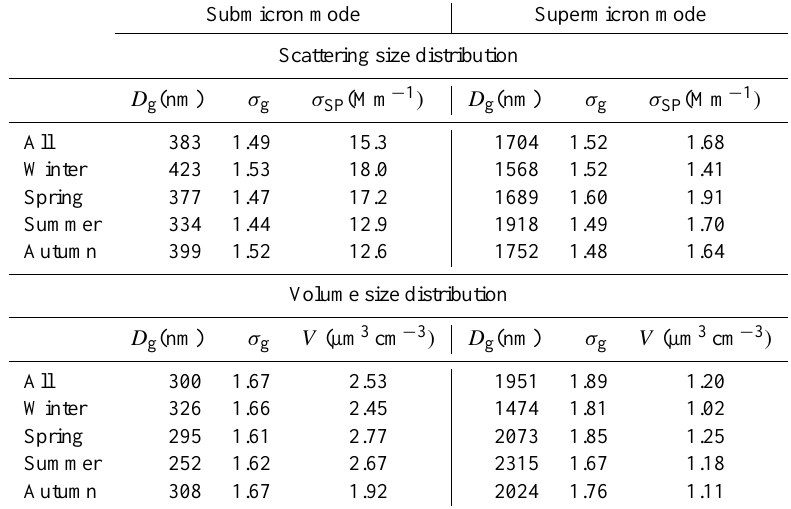
Table 3. The modal parameters of the major modes of scattering ( λ = 550nm) and volume size distributions obtained from fitting lognormal modes to the average size distribution of all data, and the averages of the four seasons. D g is the geometric mean and σ g the geometric standard deviation of the mode, σ SP is the integrated scattering of the mode and V is the integrated volume of the mode.